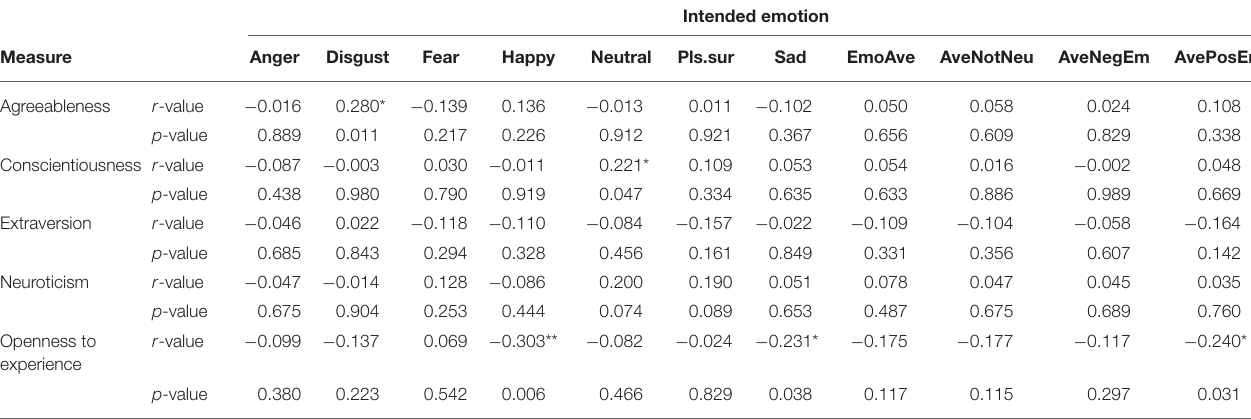
TABLE 3 | Study 1: Pearson’s correlations ( R -value) and their significance level (* P < 0.05) between H u scores and the Big Five Inventory